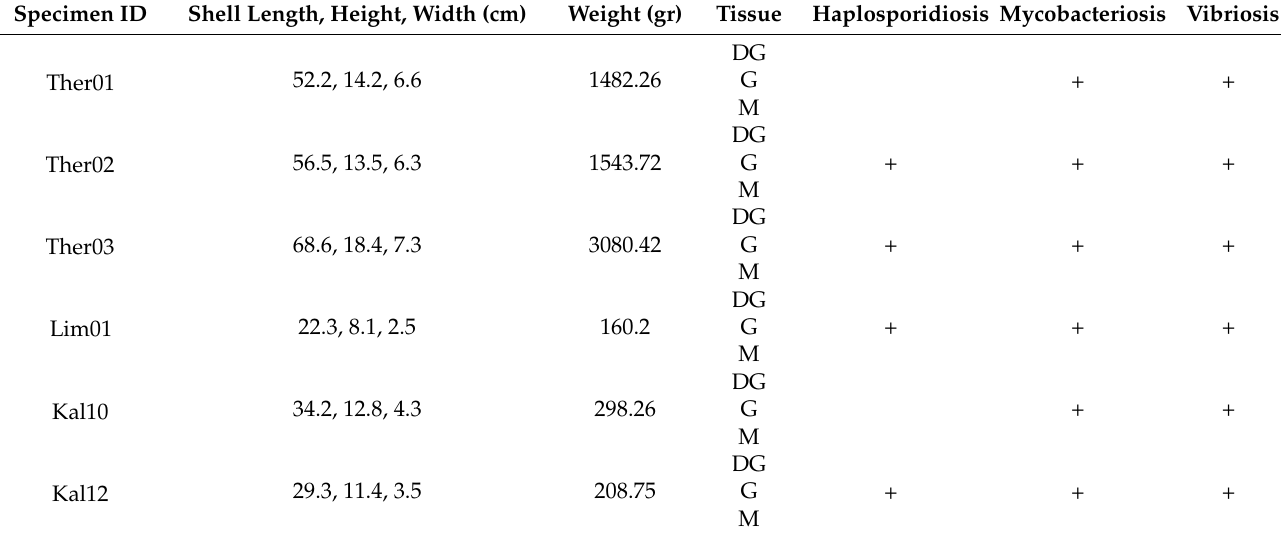
Table 1. Data of the specimens used for the